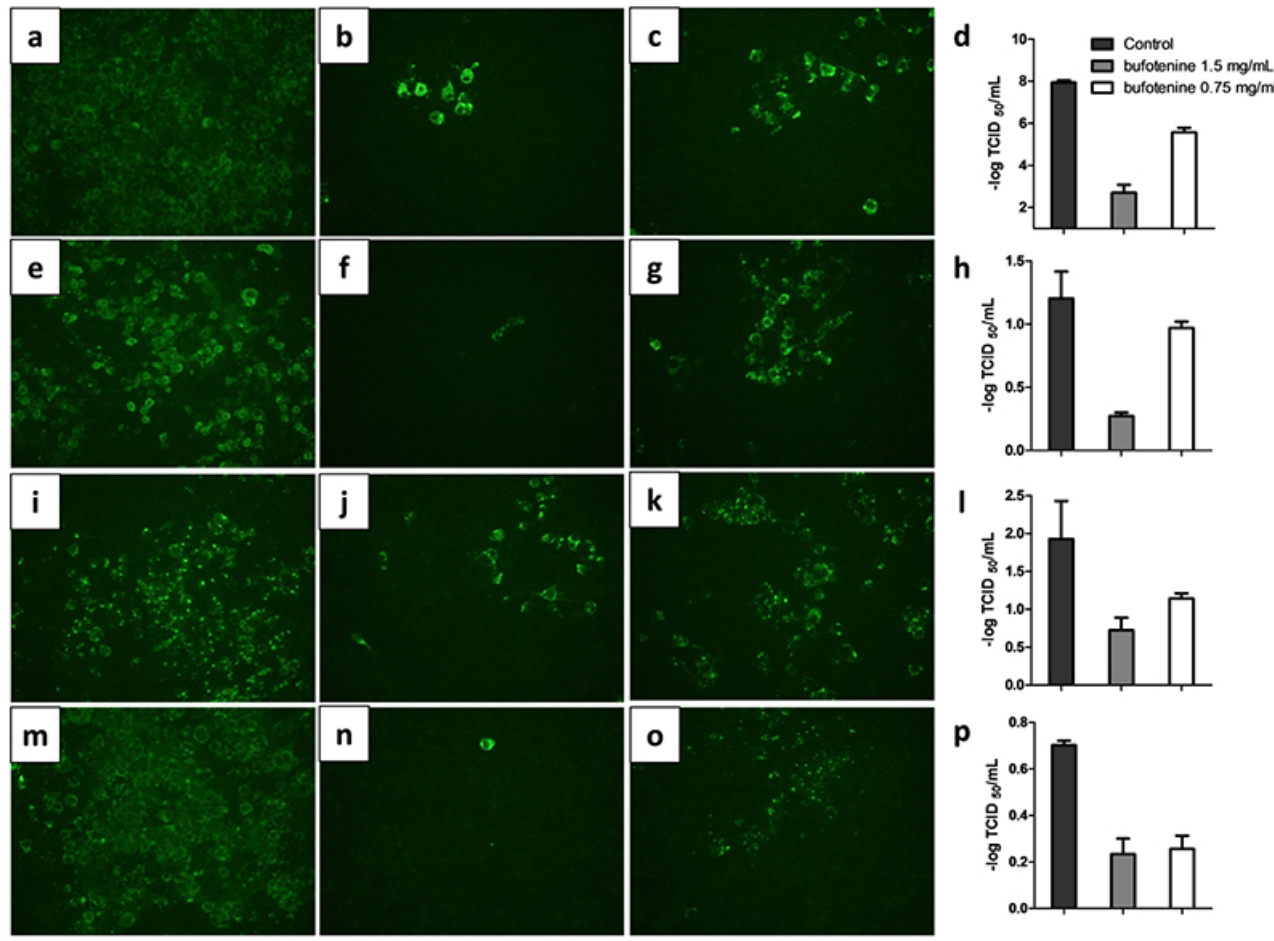
Figure 1. Bufotenine inhibits different RABV strains in N2A cells. Inhibition of challenge virus standard (CVS): (a) control; (b) bufotenine concentration of 1,5 mg/mL; (c) bufotenine concentration of 0.75 mg/mL; (d) supernatant virus titration. Inhibition of dog lineage RABV isolated from dog central nervous system sample: (e) control; (f) bufotenine concentration of 1.5 mg/mL; (g) bufotenine concentration of 0.75 mg/mL; (h) supernatant virus titration. Inhibition of Eptesicus furinalis lineage RABV isolated from bat central nervous system sample: (i) control; (j) bufotenine concentration of 1.5 mg/mL; (k) bufotenine concentration of 0.75 mg/mL; (l) supernatant virus titration. Inhibition of Desmodus rotundus lineage RABV isolated from bovine central nervous system sample: (m) control; (n) bufotenine concentration of 1.5 mg/mL; (o) bufotenine concentration of 0.75 mg/mL; (p) supernatant virus